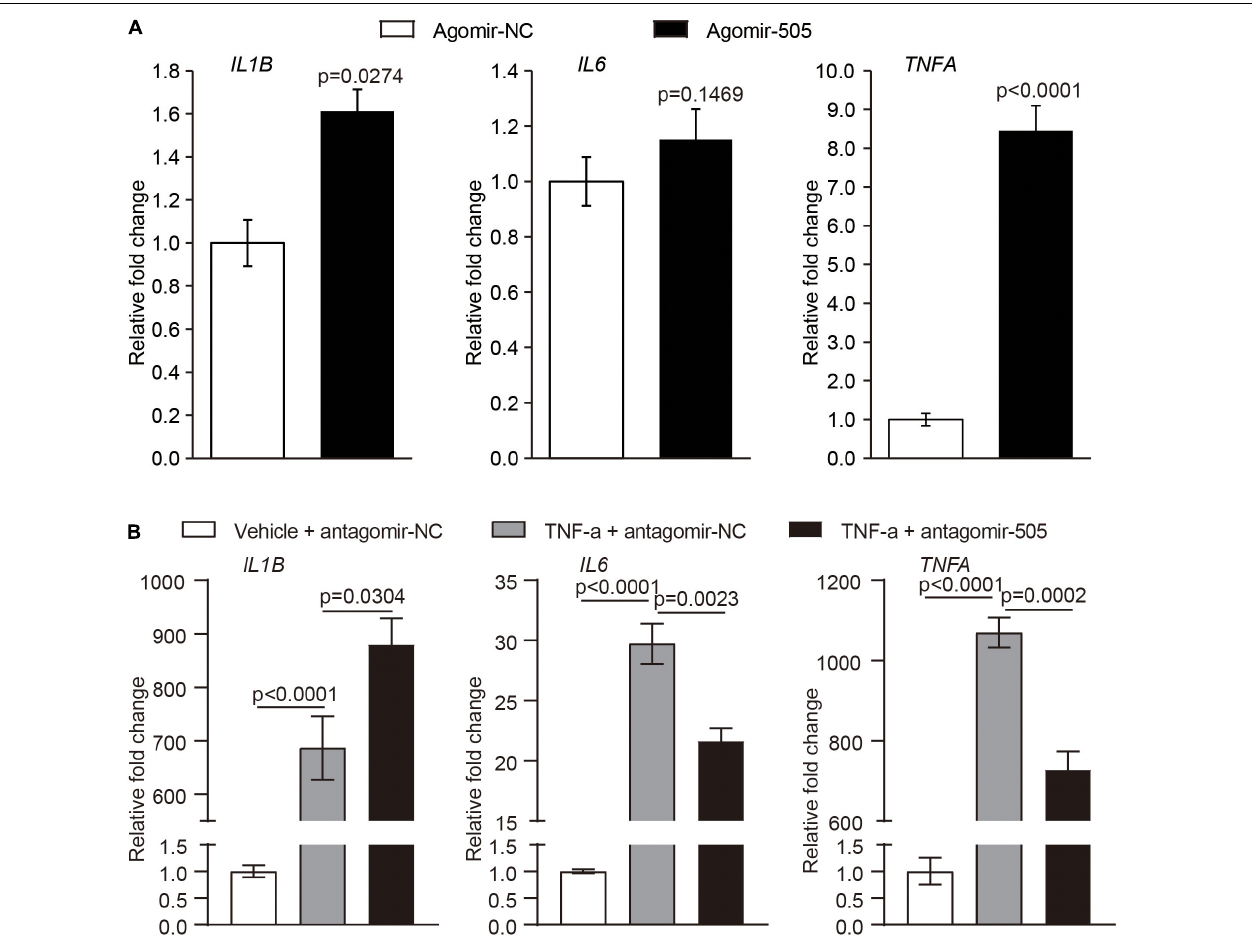
FIGURE 5 | MiR-505 upregulates the expression of proinflammatory genes in endothelial cells. (A) Agomir-505 or agomir-NC was transfected in HUVECs, followed by real-time qPCR analysis of the expression of IL1B , IL6 and TNFA . Relative fold change of gene expression was plotted against that from agomir-NC-transfected HUVECs ( n = 6 per group). Data represent mean ± SEM. P values are derived from the Student’s t -test. (B) Antagomir-505 or antagomir-NC was transfected in HUVECs, followed by 2 ng/mL TNF- α stimulation for 16 h. The expression of IL1B , IL6 and TNFA was then examined by real-time qPCR analysis. The relative fold change of gene expression was plotted against that from antagomir-NC-transfected HUVECs in the absence of TNF- α stimulation (vehicle + antagomir-NC) ( n = 6 per group). Data represent mean ± SEM. P values are derived from one-way ANOVA and the Student’s t